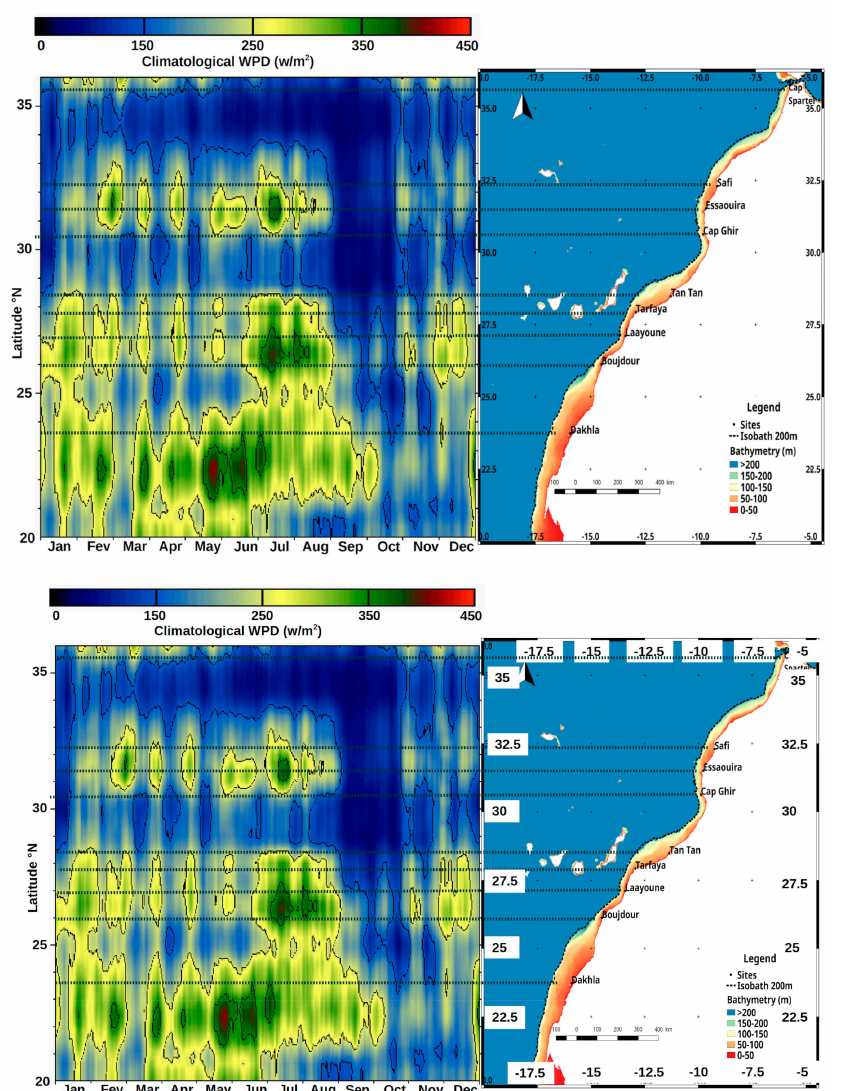
Figure 11. Seasonal mean of the power wind energy density.